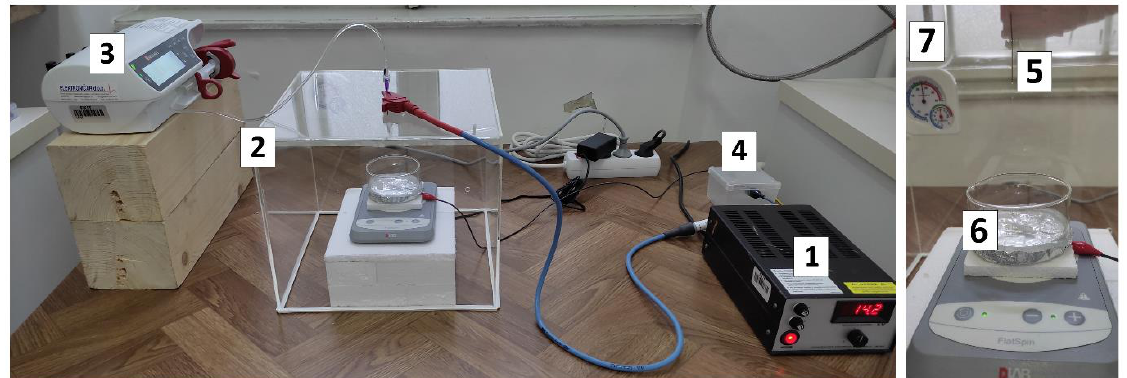
Figure 1. Electrospraying apparatus: (1) high voltage generator, (2) poly(methyl- methacrylate) chamber, (3) syringe pump with different needle gauges for feeding the test solution and (4) grounding. In the chamber were: (5) metal needle with obtained Taylor cone-jet, (6) collector (crystallizing dish with flat bottom, with 50 mL of 5 wt.% NaOH solution and magnetic stirring bar, isolated with aluminum foil) and (7) temperature and relative humidity sensor.